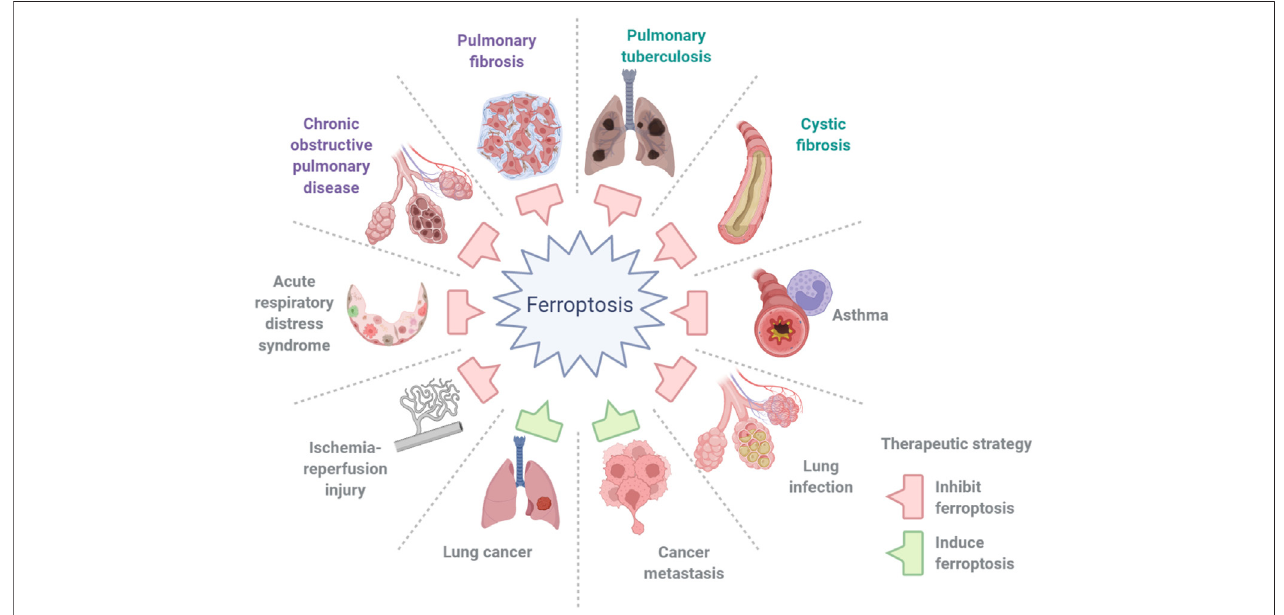
FIGURE 2 | Ferroptosis in lung diseases. Ferroptosis contributes greatly to the pathogenesis of lung diseases, including chronic obstructive pulmonary disease, asthma,cystic fi brosis,pulmonary fi brosis,ischemia – reperfusioninjury,pulmonaryinfections,acutelunginjuryandacuterespiratorydistresssyndrome,andlungcancer and